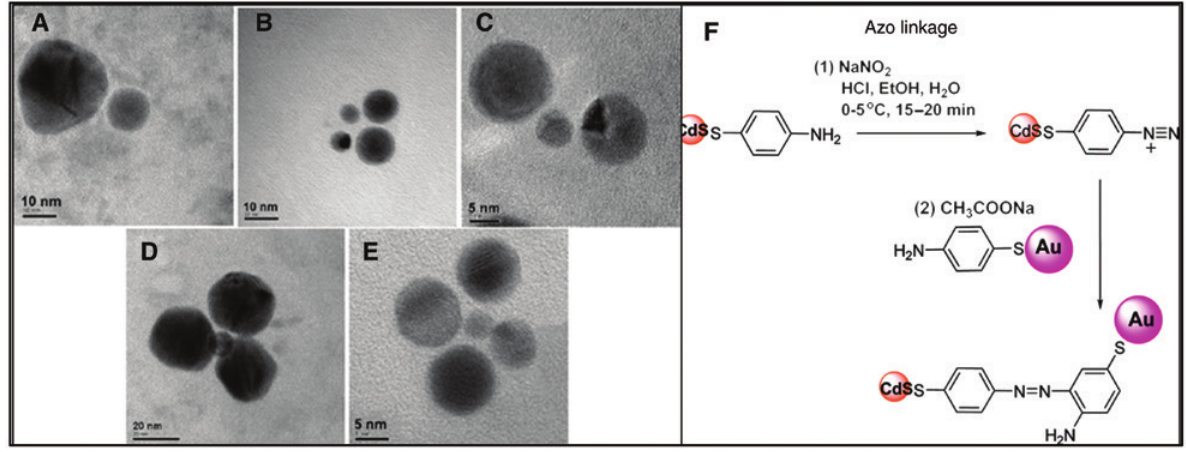
Figure 1: Covalent linkage of AuNPs and CdS